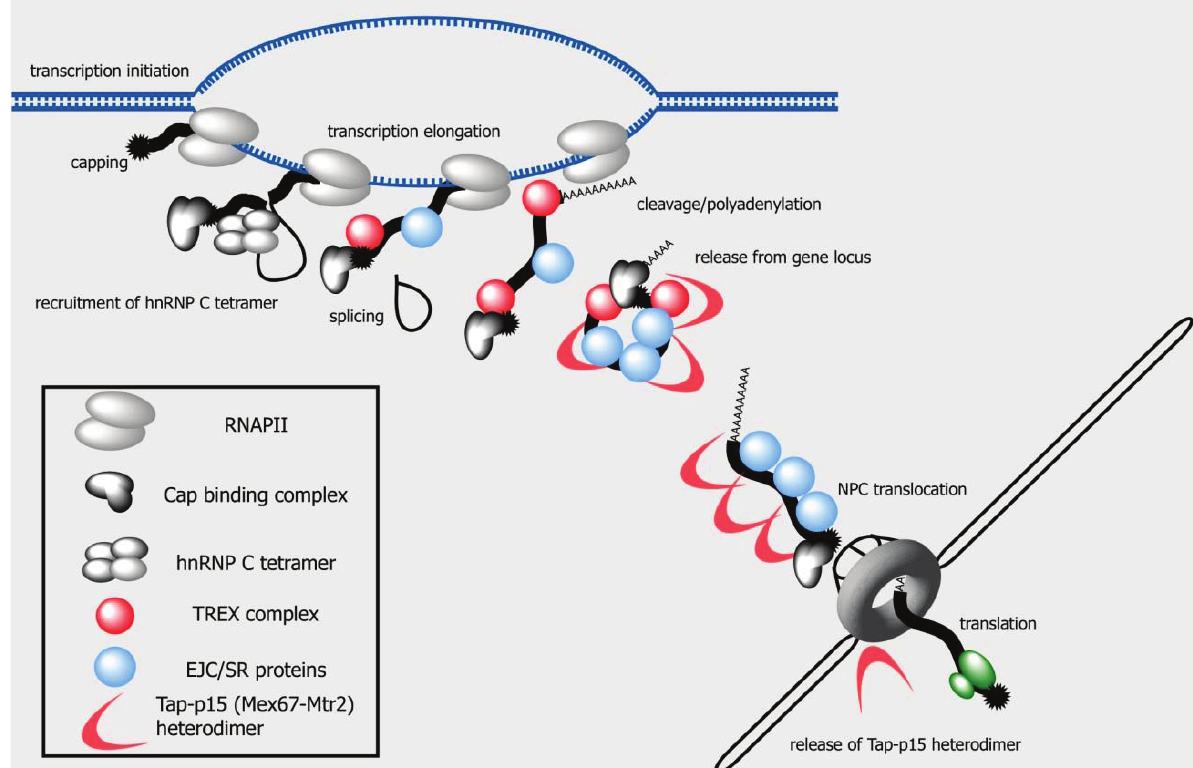
Figure 1. A brief overview of mRNA nuclear export. During transcription, protein factors required for capping, splicing and cleavage/polyadenylation are recruited to the nascent transcript, forming an mRNP. The 5' end of the mRNA is capped early in this process via an interaction between the capping enzyme and RNA polymerase II (RNAPII).